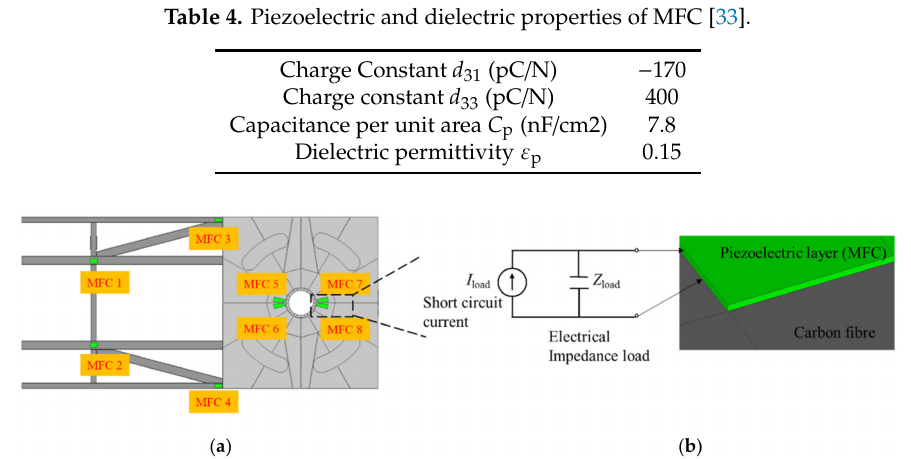
Table 4. Piezoelectric and dielectric properties of MFC [33].